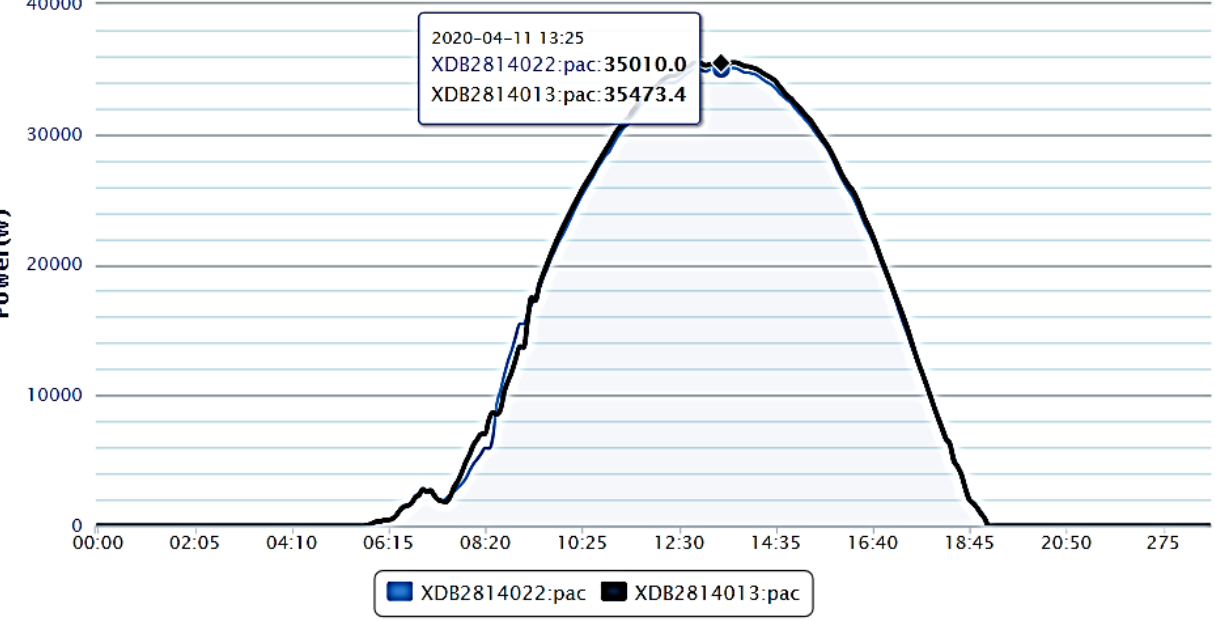
Figure 5. Power generated by two micro-installations of 2 × 40 kWp on 11 April 2020.